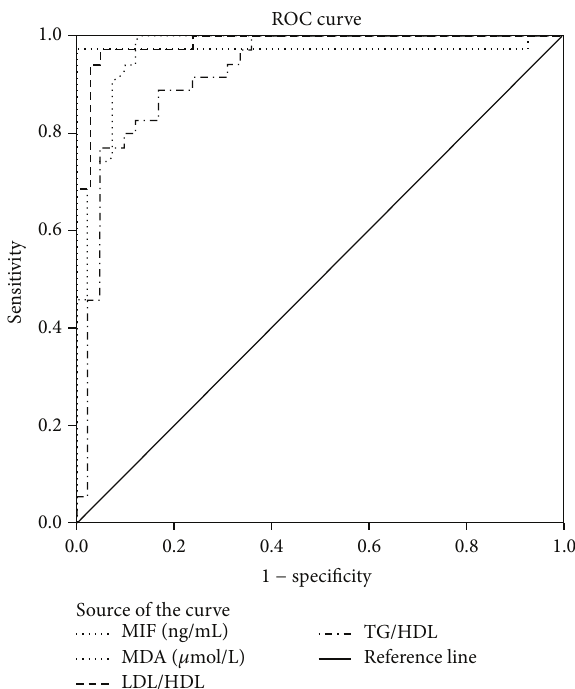
Figure 1: ROC curve analysis of the studied potential predictors of diabetic